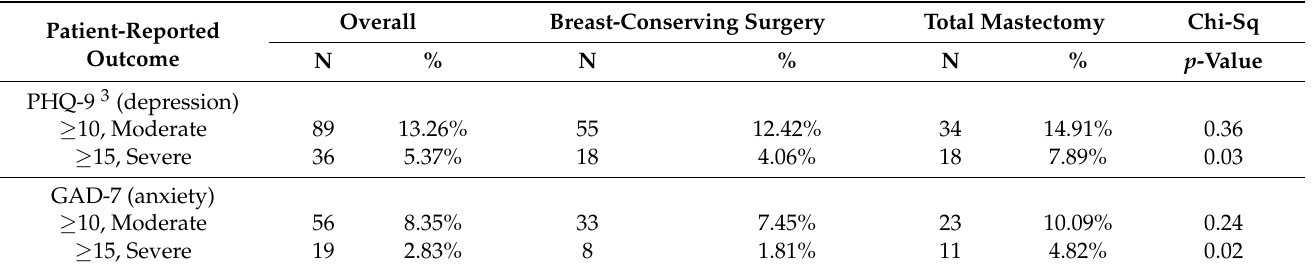
Table 3. Number and proportion of participants reporting symptoms of depression (PHQ-9) and anxiety (GAD-7) that exceeded clinical thresholds. Sample size equals 671